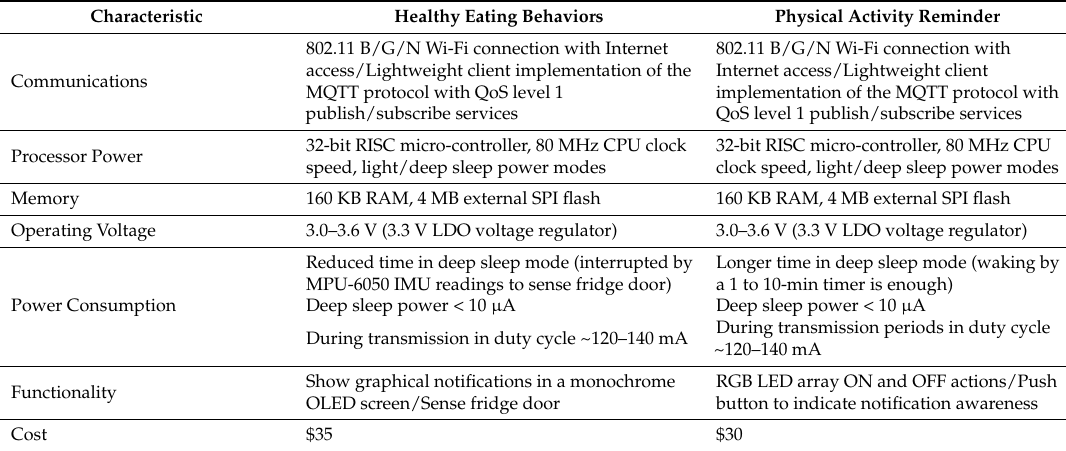
Table 1. Dedicated devices hardware